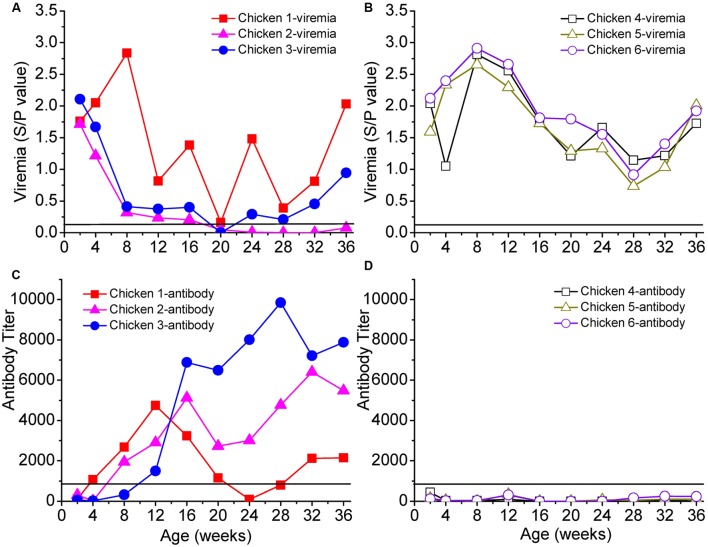
Viremia and neutralizing antibodies of six selected chickens. Panel (A) shows the persistent viremia of chickens 1, 2, and 3, and panel (B) shows the persistent viremia of chickens 4, 5, and 6. Panels (C,D) show the antibody responses of chickens 1–3 and 4–6, respectively. The x-axis represents the ages of the chickens in weeks. Solid lines in each panel represent the cut-off values.